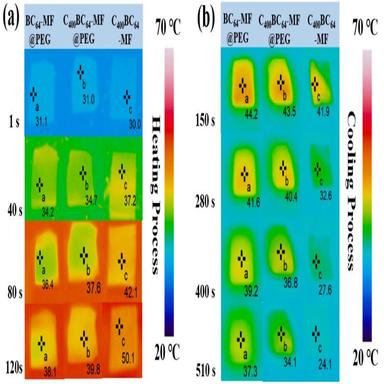
Infrared thermograms of BC64-MF@PEG, C400BC64-MF@PEG and C400BC64-MF during (a) heating and (b) cooling processes.